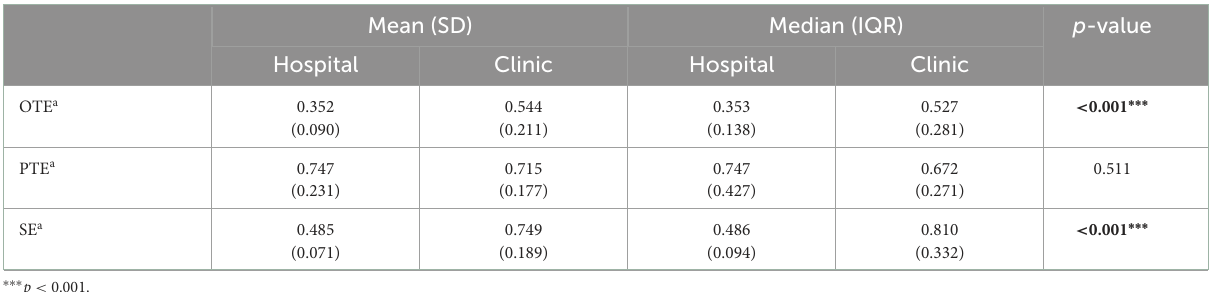
TABLE 5 OTE, PTE, and SE by type of health facility ( n = 76).